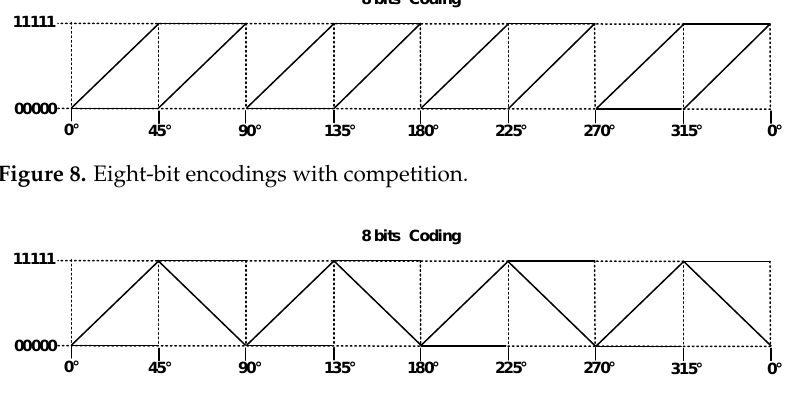
Figure 9. Eight-bit encodings without